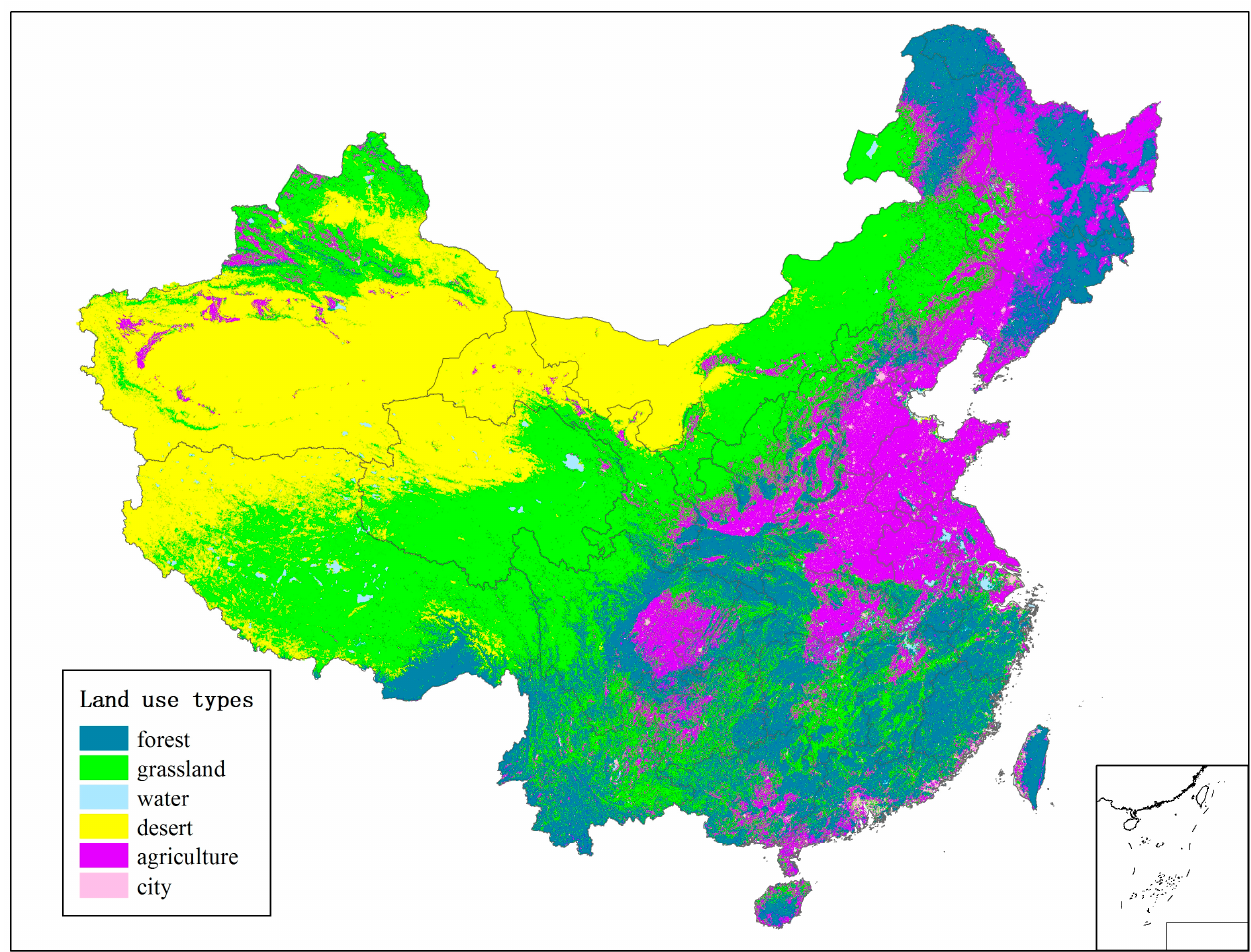
Figure 1. The main land-use types in China.